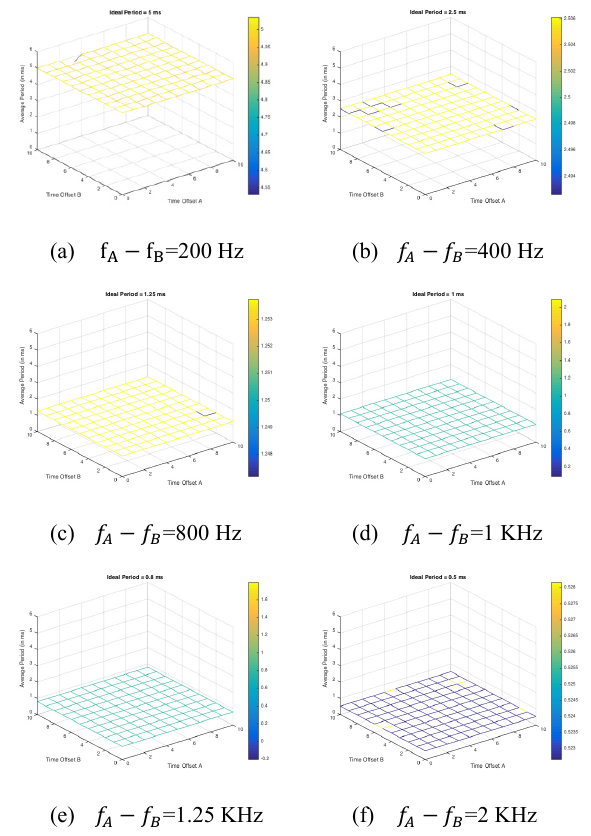
Fig. 8. Average Period of Average-RSS-Time Curve under Different Time Offsets